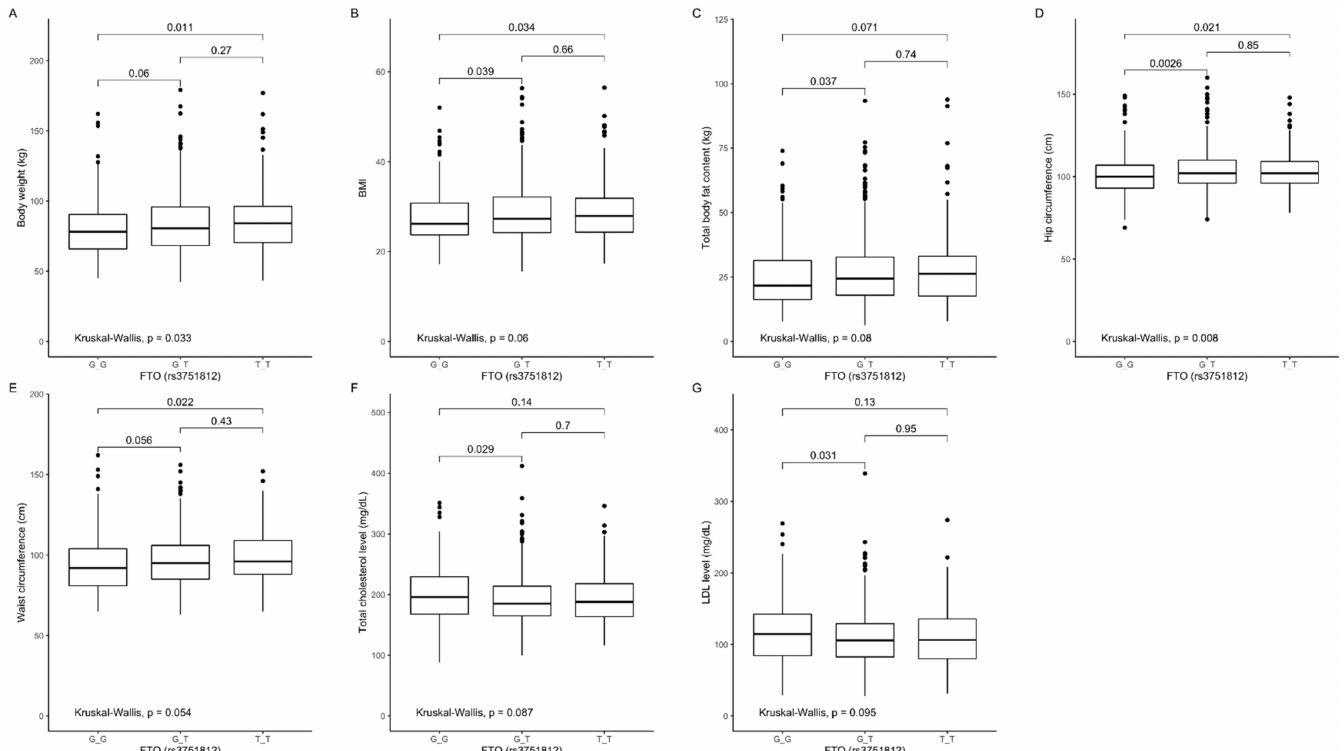
Figure 1. Association of fat mass and obesity-associated ( FTO ) genotype rs3751812 with ( A ) body weight (kg), ( B ) BMI (kg / m 2 ), ( C ) total body fat content (kg), ( D ) hip circumference (cm 3 ), ( E ) waist circumference (cm 3 ), ( F ) total cholesterol level (mg / dL), ( G ) LDL level (mg /